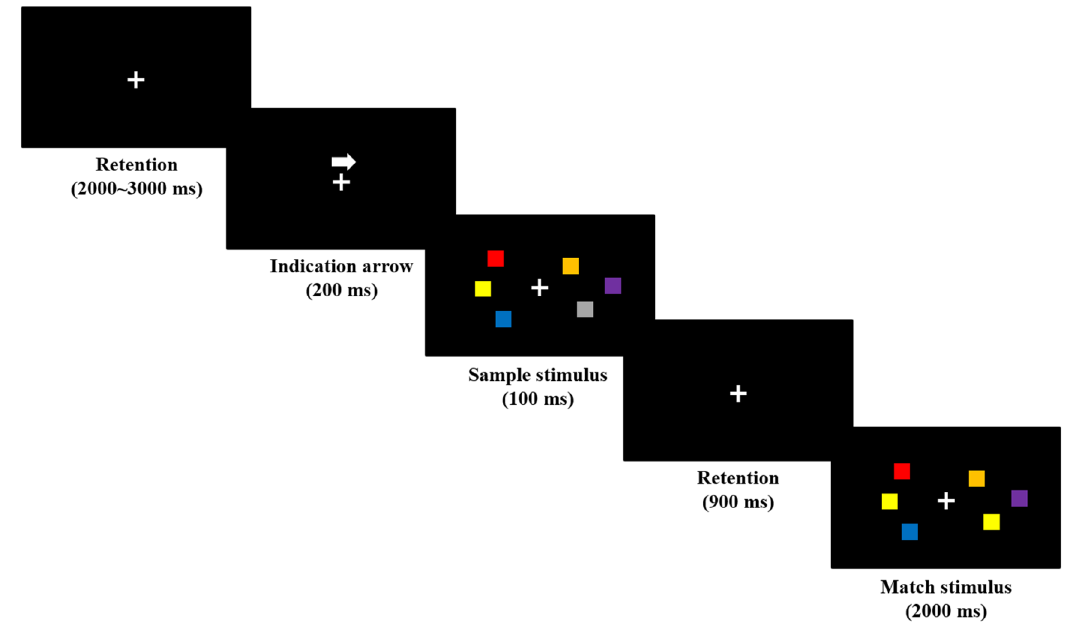
Figure 1. Flowchart of the visual match to delayed sample task. Two arrays of colored squares were presented on both sides of the fixation cross, with no square on the side sharing a color. The number of squares presented were four, five, and six on the real task (three on the figure). An indication arrow (200 ms) informing which side of the arrays were to be memorized preceded the sample stimulus (100 ms), followed by the retention period (900 ms) and match stimulus (2000 ms). When the match stimulus was presented, participants were asked to determine whether the arrays that the indication arrow pointed to have the same colors as the sample